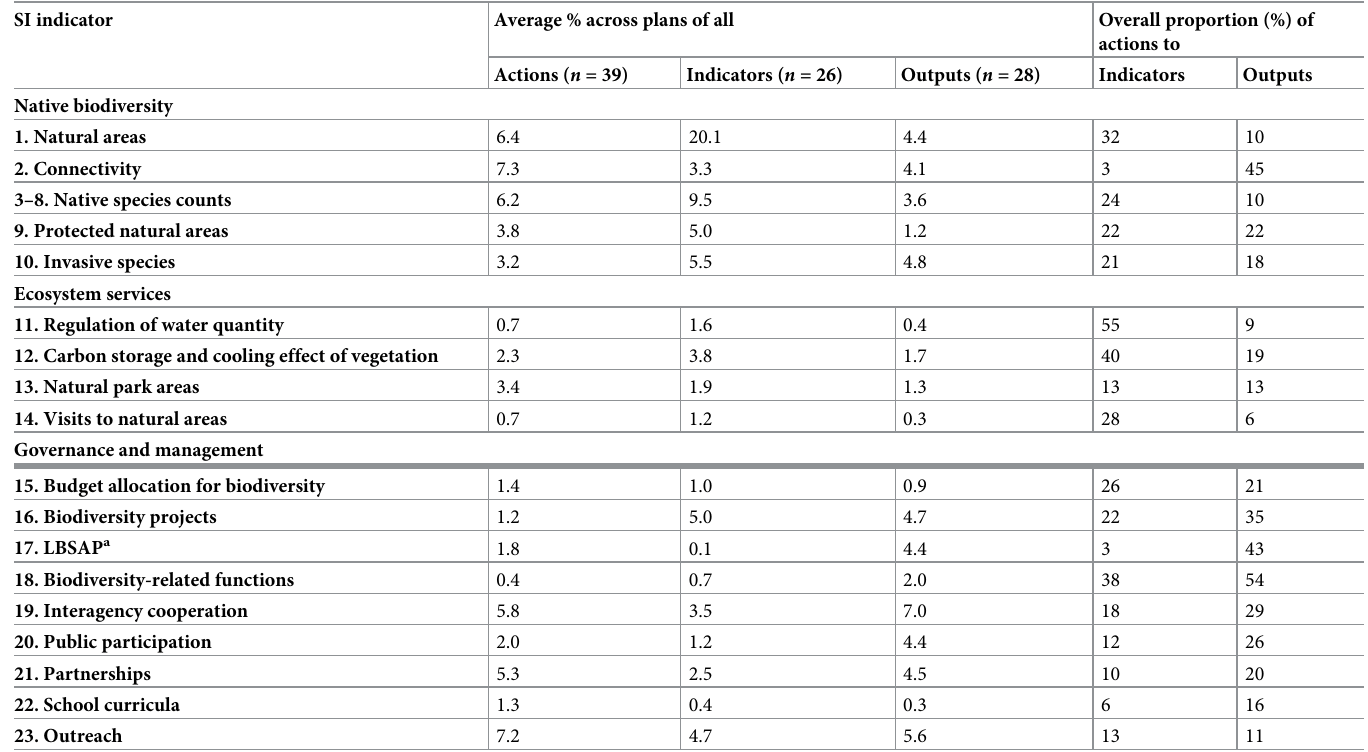
Table 3. Percentages of actions, indicators, and outputs in plans, along with percentages of actions with linked measures, classified by Singapore Index indicator. SI